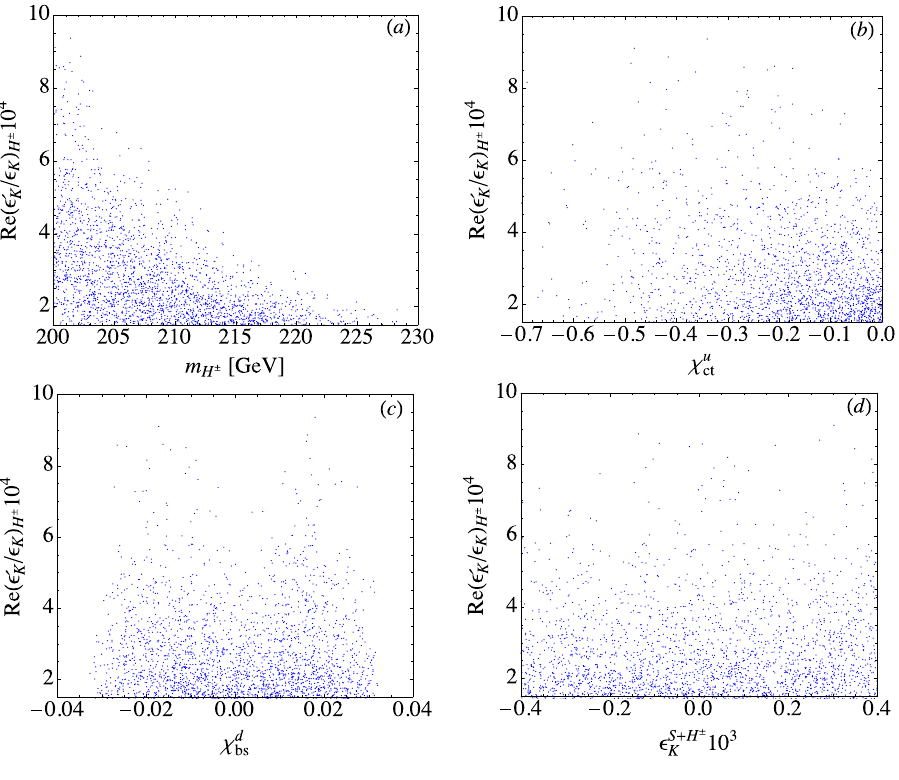
Figure 8 . Re ( (cid:15) 0 the correlation between Re ( (cid:15) 0